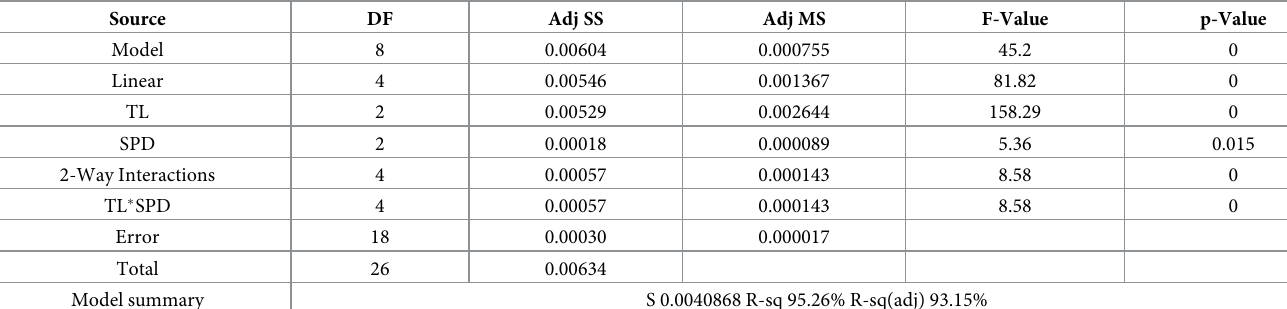
Table 7. ANOVA results for minimum